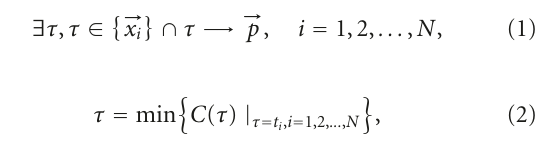
Figure 2: Geomagnetic long-term variation (for about three years) recorded in